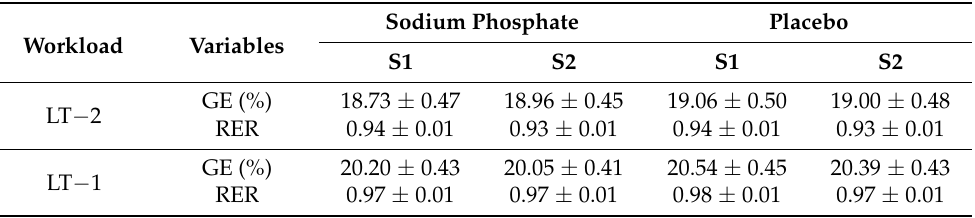
Table 3. Gross efficiency (GE) and respiratory exchange ratio (RER) during exercise in hypoxia before (S1) and after (S2) sodium phosphate and placebo